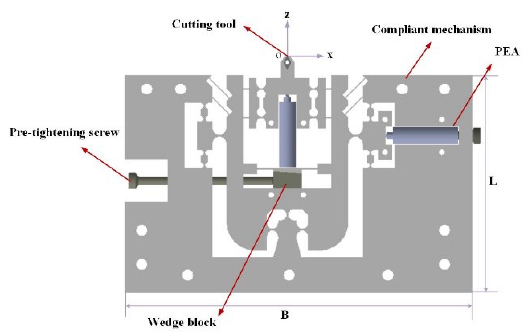
Figure 1. The mechanical structure of the 2-DOF (degrees of freedom) fast tool servo (FTS).